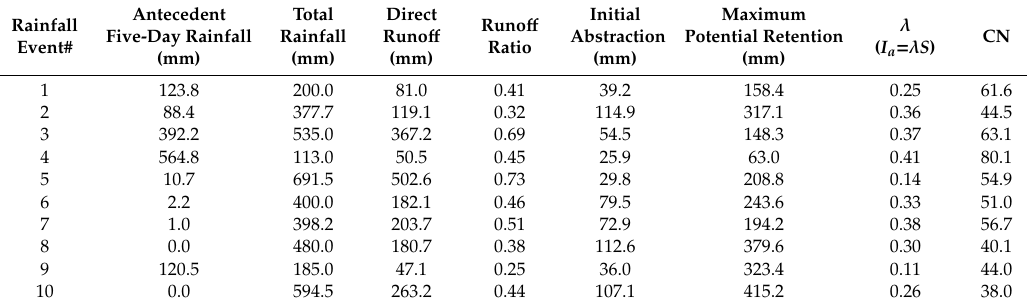
Table 3. Estimates of initial abstraction, maximum potential retention, and CN along with other basic information.